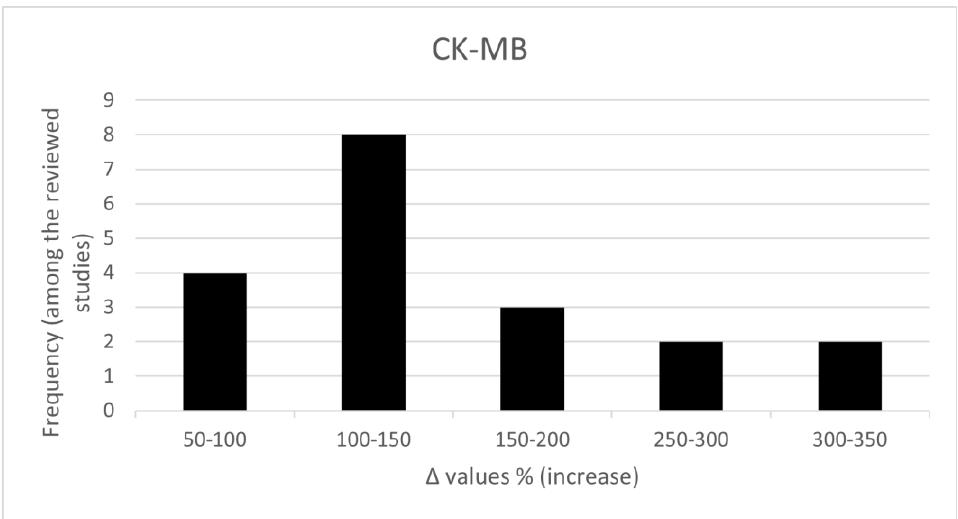
Figure 2. % Increase in CK-MB (% Δ values [(values of rats exposed to anthracyclines) − (values of control rats)] × 100) in rats exposed to anthracyclines compared to control animals, as reported in 19 relevant studies reviewed by Georgiadis et al. 2020 [17] (data from Georgiadis PhD thesis not currently published). %Δ values were calculated in order to overcome the diversity of measuring units used in the literature.